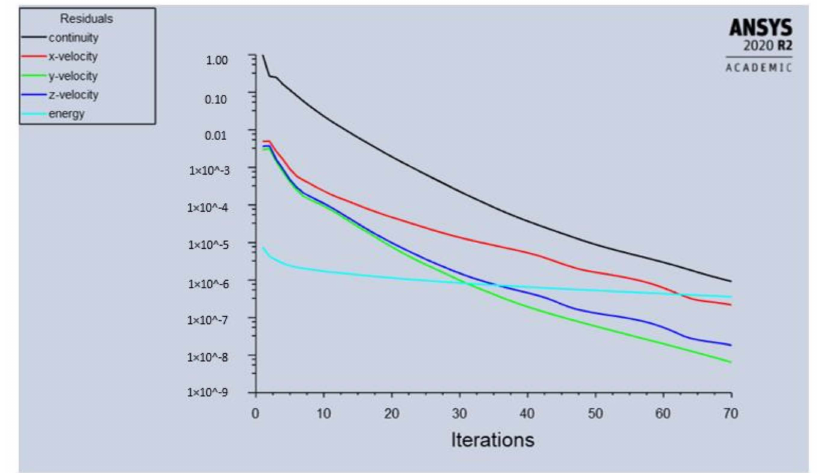
Figure 8. Converged residual plot for Design